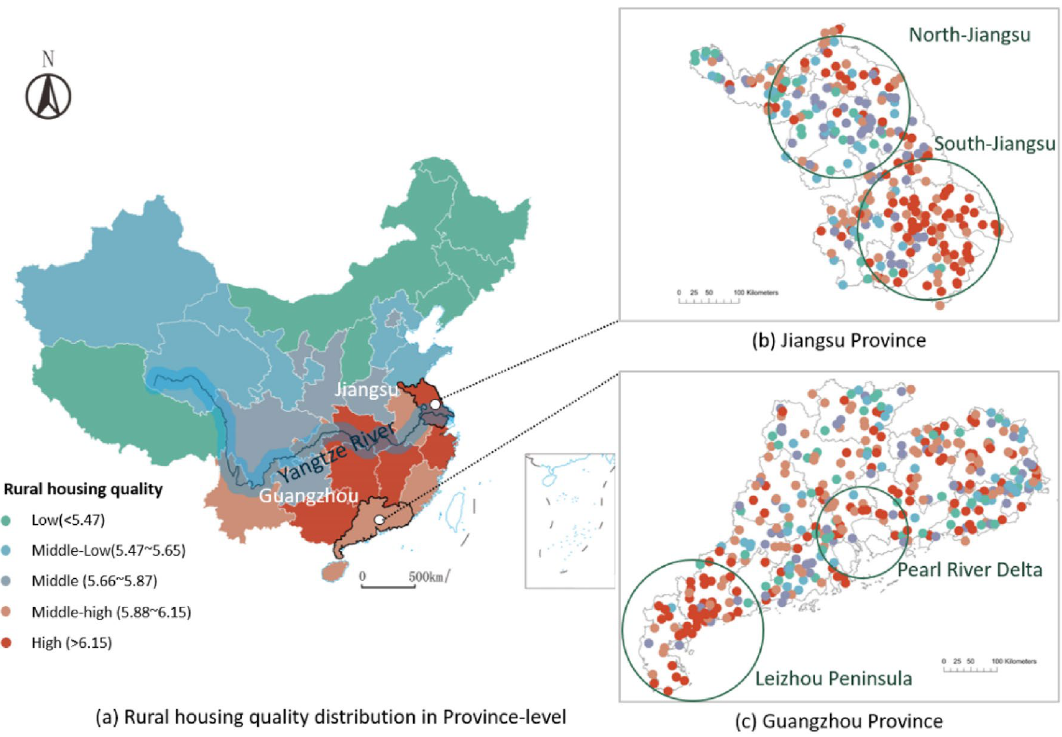
Figure 5. The distribution of rural housing quality on a regional scale. ( a ) Displays the housing quality at the province level, ( b ) looks at the Jiangsu province and ( c ) displays the housing quality at the village level. Each dot represents one village. The map is created by Arcgis 10.0, and the base map is provided by Standard Map Service System (http:// bzdt. ch. mnr. gov. cn).